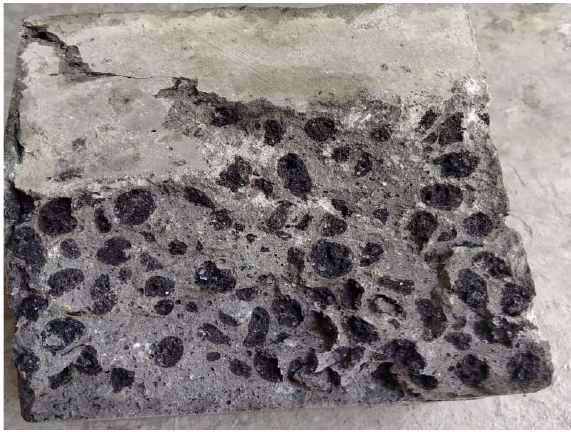
Figure 6. LECA concrete cube after testing for compression.